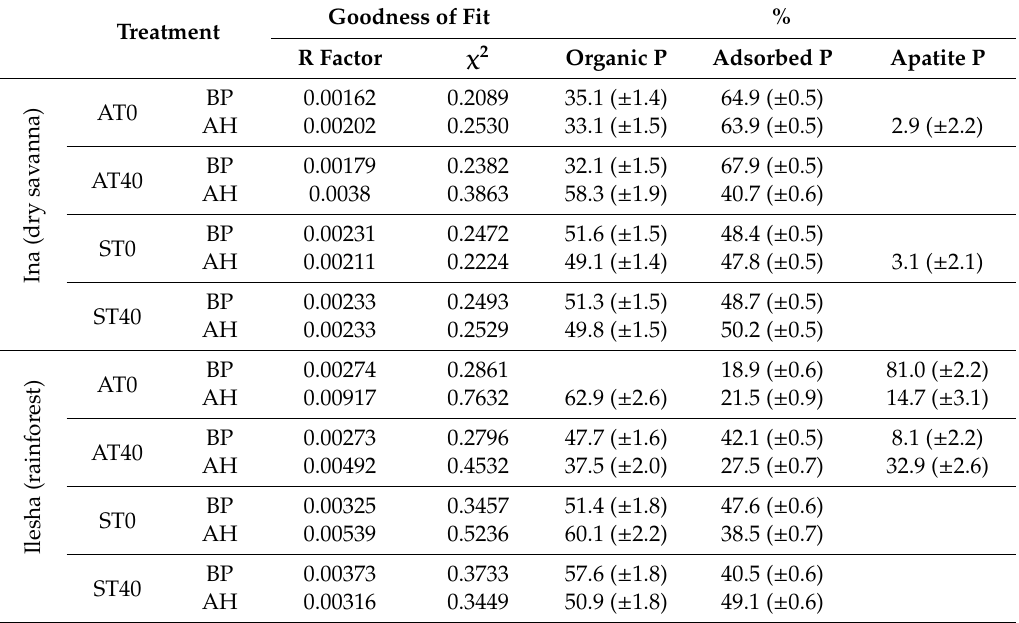
Table 3. Proportion of P species in the amended soils from linear combination fitting (standard error of the fit in